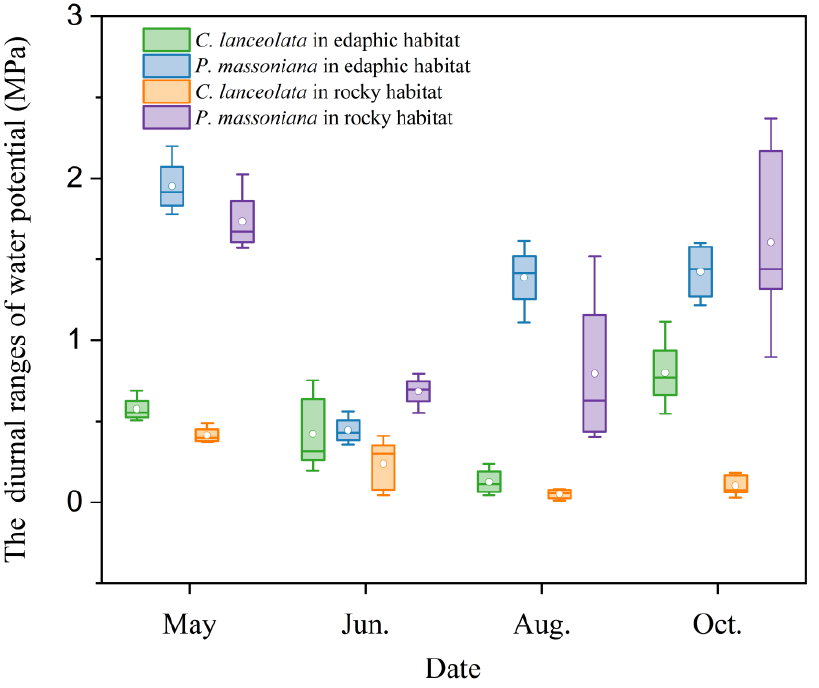
Figure 9. Variation in mean ( ± S.D.) diurnal ranges of water potential for C. lanceolata and P. massoniana during the wet season.